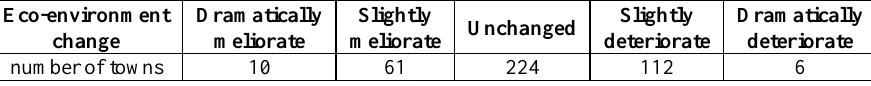
Table 3. Statistical data of eco-environment status